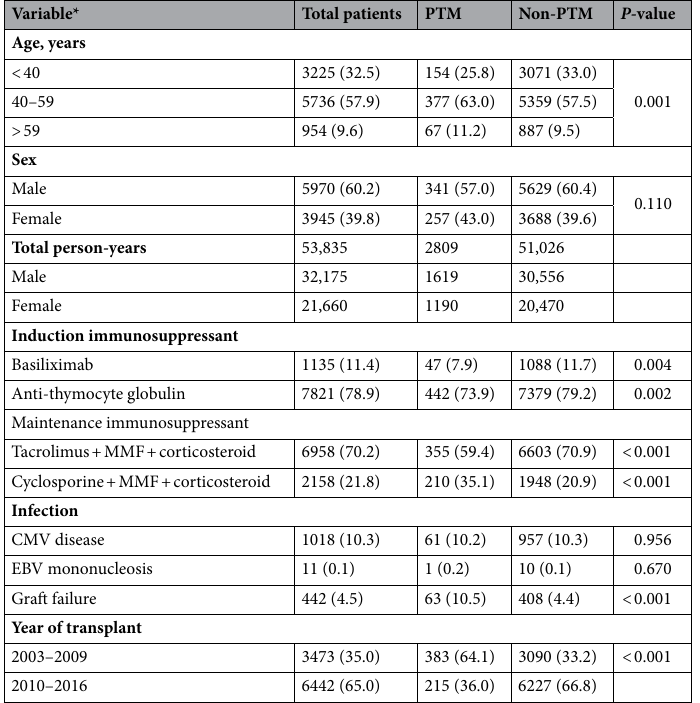
Table 1. Comparison of characteristics between patients with post-transplant malignancies (PTM) versus without PTM. CMV cytomegalovirus, EBV Epstein–Barr virus, MMF mycophenolate mofetil, PTM post- transplant malignancy. *Data are expressed as number and